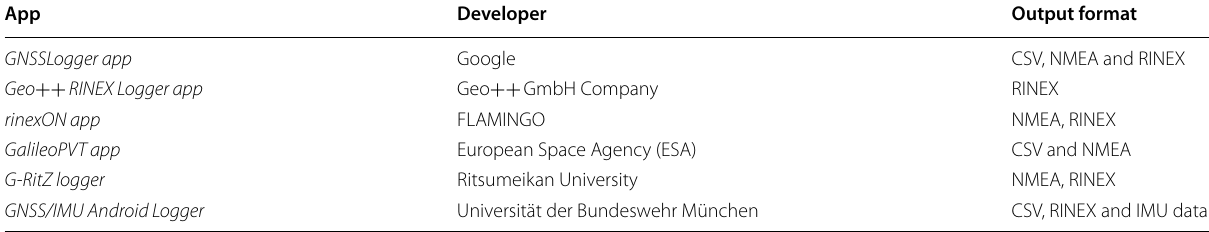
Table 4 Available GNSS logger Android